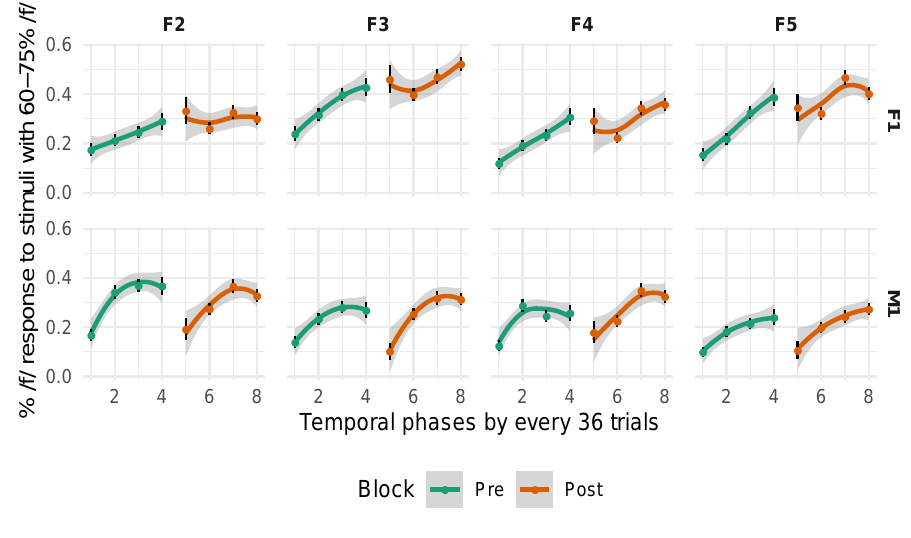
Figure 4: Pre-test and post-test syllable classi(cid:976)ication by trial